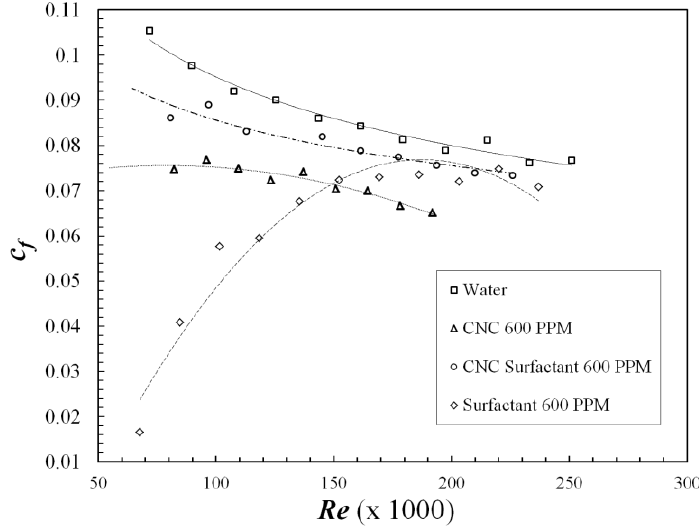
Figure 8. Skin friction Coefficient vs. Reynolds number for CNC, Surfactant and CNC-Surfactant.